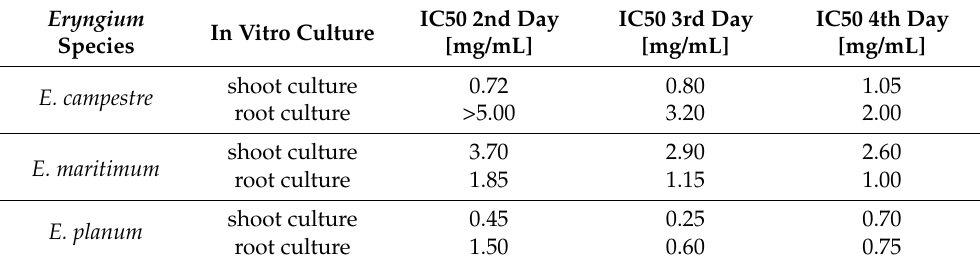
Table 8. Determination of IC 50 [mg/mL] for the studied extracts of Eryngium extracts on Acanthamoeba trophozoites proliferation in the culture